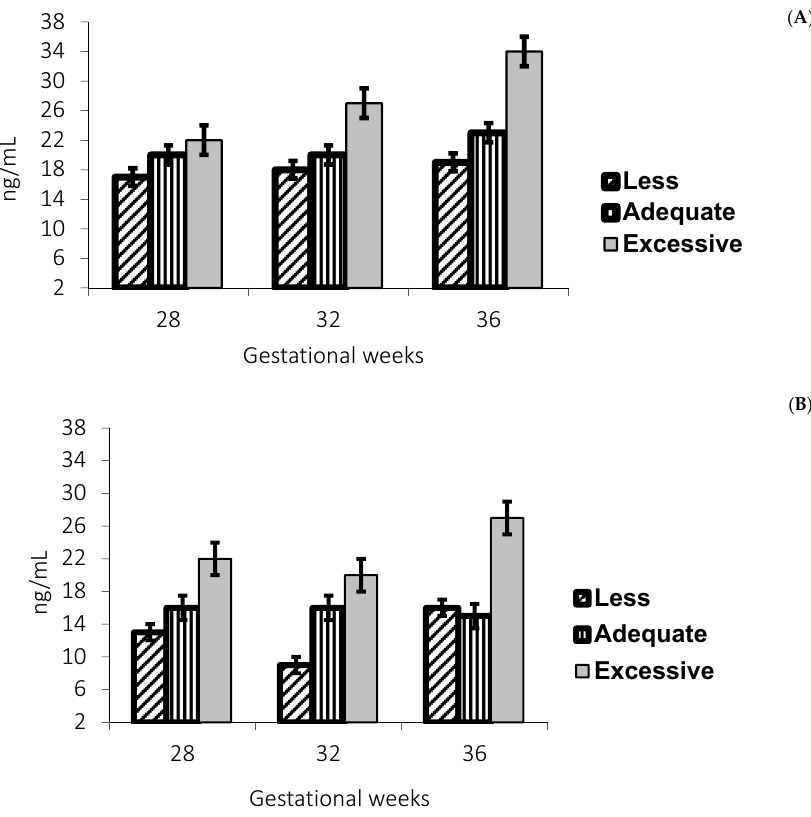
Figure 3. In ( A ), at Gestation Week 28 p = 0.027, post hoc less vs. excessive p = 0.008; at Gestation Week 32 p = 0.001, post hoc less vs. excessive p = 0.001, adequate vs. excessive p = 0.003; and at Gestation Week 36 p = 0.001, post hoc less vs. excessive p = 0.001, adequate vs. excessive 0.001. In ( B ), at Gestation Week 28 p = 0.001, post hoc less vs. excessive p = 0.001, adequate vs. excessive p = 0.014; at Gestation Week 32 p = 0.004, post hoc less vs. excessive p = 0.001, adequate vs. excessive p = 0.043; and at Gestation Week 36 p = 0.054, post hoc less vs. excessive p = 0.057, adequate vs. excessive 0.031. Leptin concentrations (ng/mL) at 28, 32 and gestation week 36, according to gestational weight gain, in adolescents according pregestational BMI: ( A ) low and normal n = 134; and ( B ) overweight and obese n =